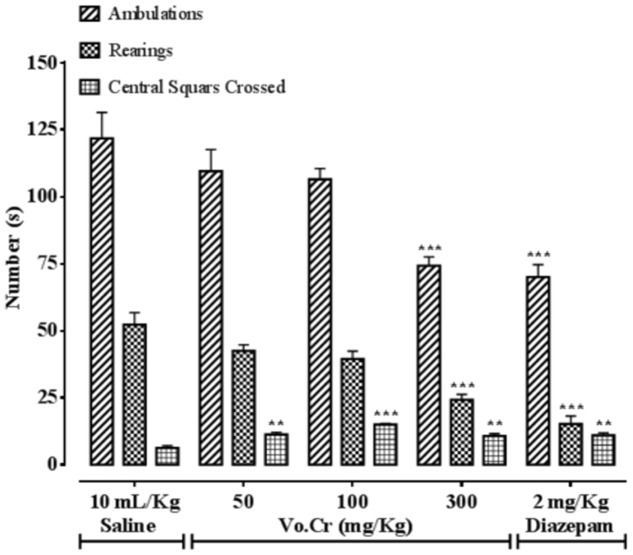
Bar-graph showing effects of Verbena officinalis crude extract (Vo.Cr) and diazepam on numbers of mice ambulations, rearings, and central squares crossings in open field model. Data expressed as mean ± SEM, n = 4. ∗∗P < 0.01, ∗∗∗P < 0.001 vs. saline group, one-way ANOVA with post hoc Tukey test.